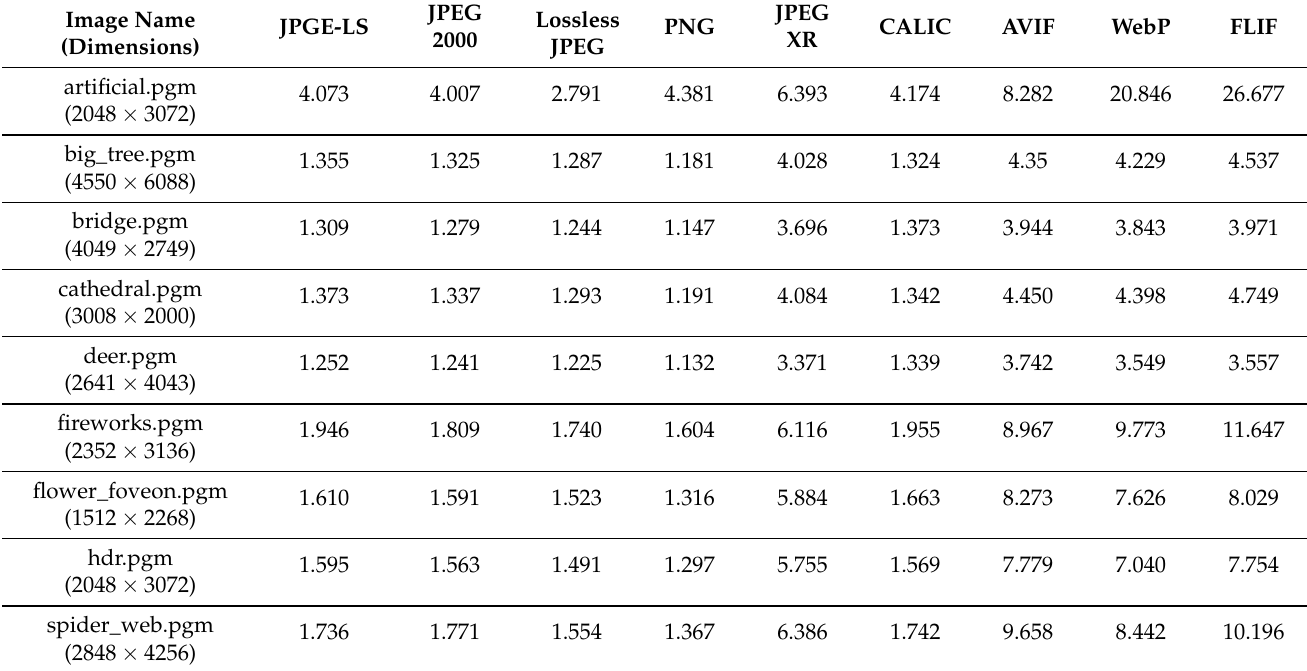
Figure 23, Table 8, and Figures 24 and 25 show the 16-bit RGB images and their CRs , ETs , and DTs , respectively. From Table 8, it can be seen that FLIF gives the highest CRs (37.021 and 12.283) for artificial.ppm and fireworks.ppm, respectively, and AVIF for